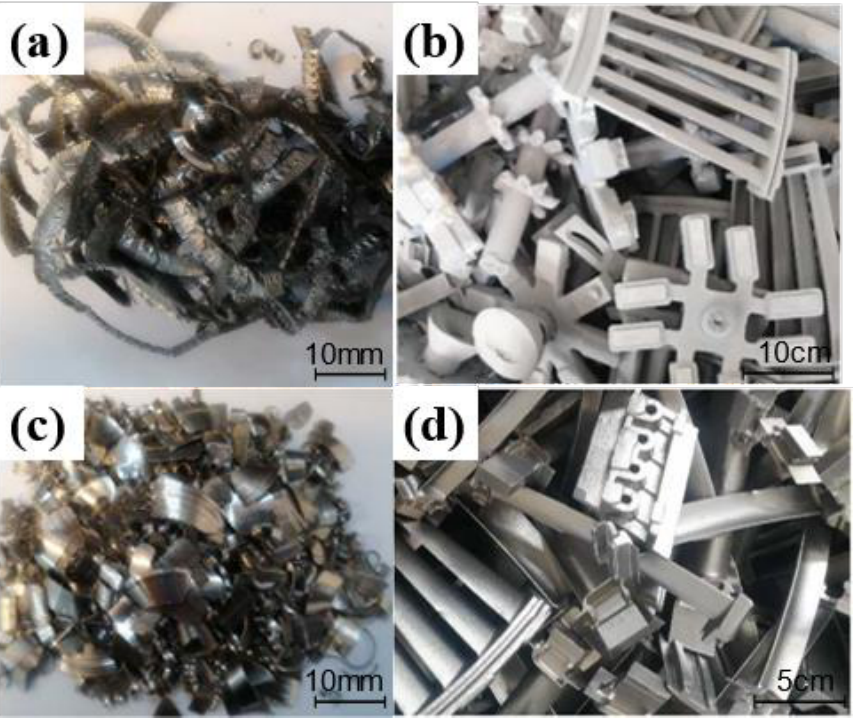
Figure 1. Returned materials before cleaning—( a ) chip-shaped and ( b ) block-shaped—and after cleaning—( c ) chip-shaped and ( d ) block-shaped. Table 1. Experimental scheme with different mass ratio of return materials.